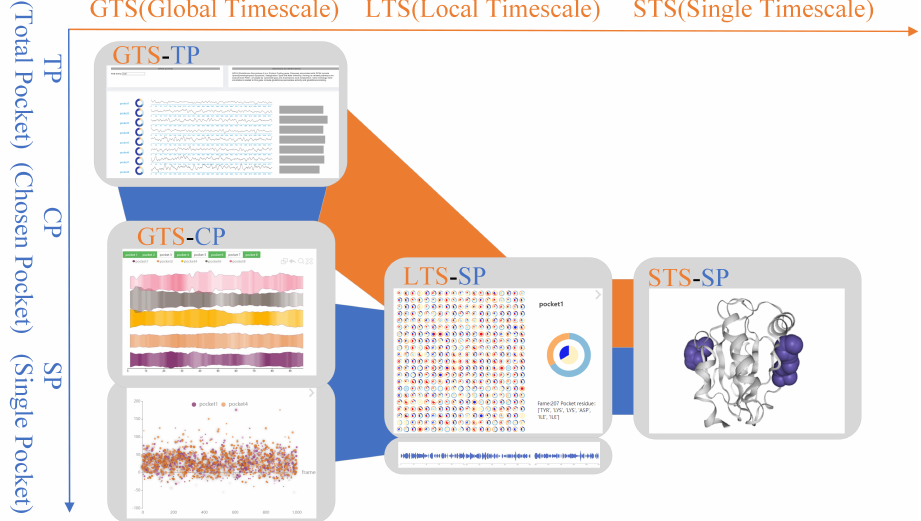
Figure 2. Visual analysis pipeline from temporal–spatial dimensions. The horizontal axis represents time scales (GTS, LTS, STS). The vertical axis represents spatial scales (TP, CP, SP). In the middle are the four scales (GTS-TP, GTS-CP, LTS-SP, STS-SP). According to the spatial scales, VAPPD is divided into three scales from left to